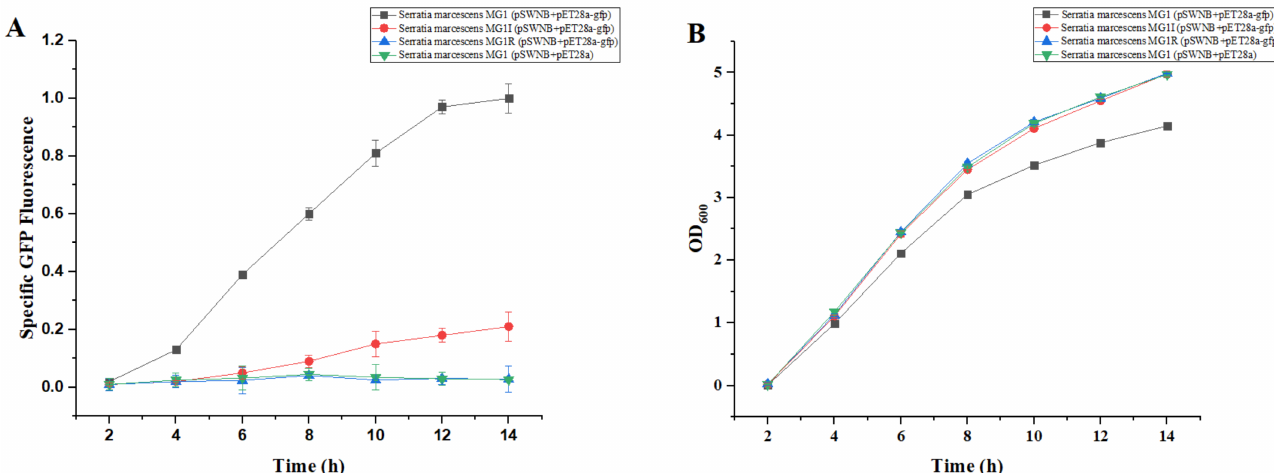
Figure 3. Comparison of specific GFP levels ( A ) and cell growth ( B ) and in LB medium. Square, Serratia marcescens MG1 (pSWNB+pET28a-gfp); Sphere, Serratia marcescens MG1I (pSWNB+pET28a-gfp); Regular Triangle, Serratia marcescens MG1R (pSWNB+pET28a-gfp); Inverse triangle, Serratia marcescens MG1